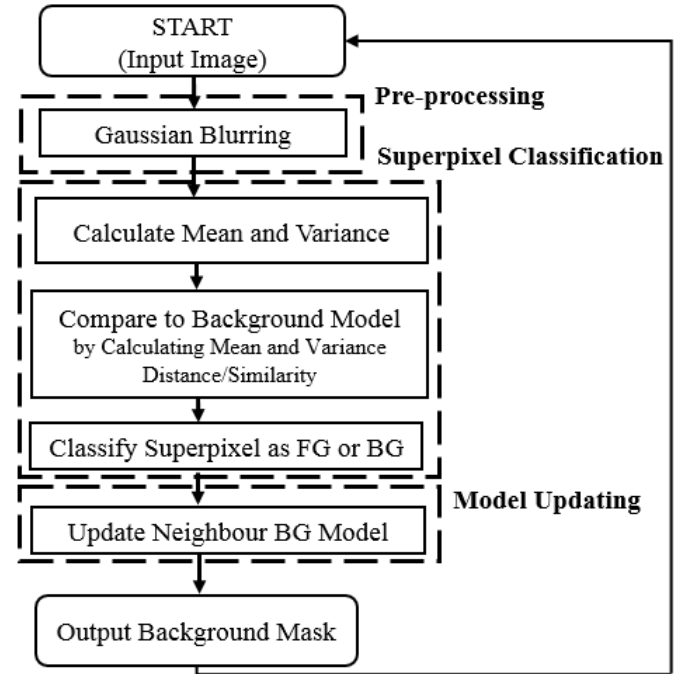
Figure 4. Flowchart of the simplified Greyscale + Integer algorithm for embedded